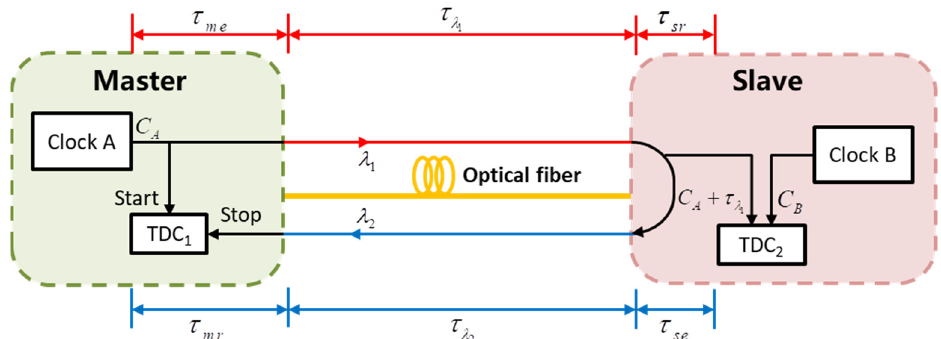
Figure 1. The principle of optical fiber time synchronization system based on round-trip method.